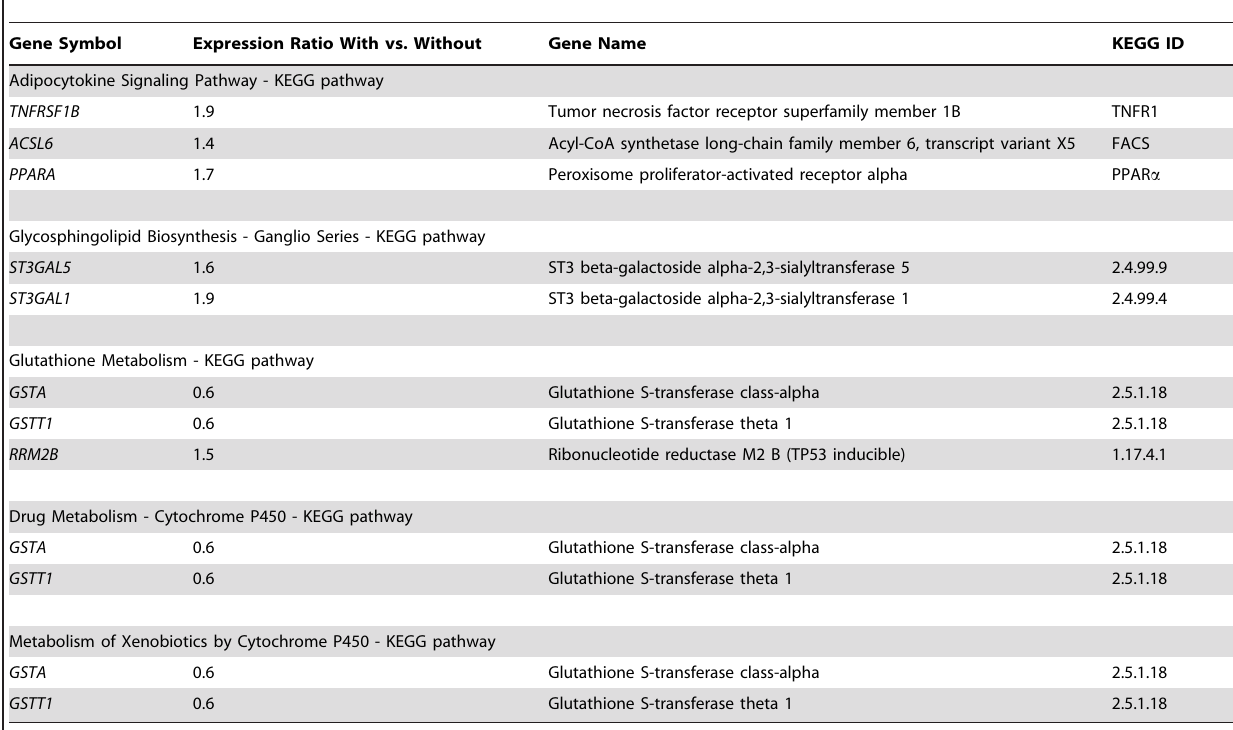
Table 2. List of chicken genes from KEGG pathway maps differentially expressed in liver from animals supplemented with 5 g of inulin kg 2 1 diet and controls, with expression ratio, annotated gene description and KEGG ID.